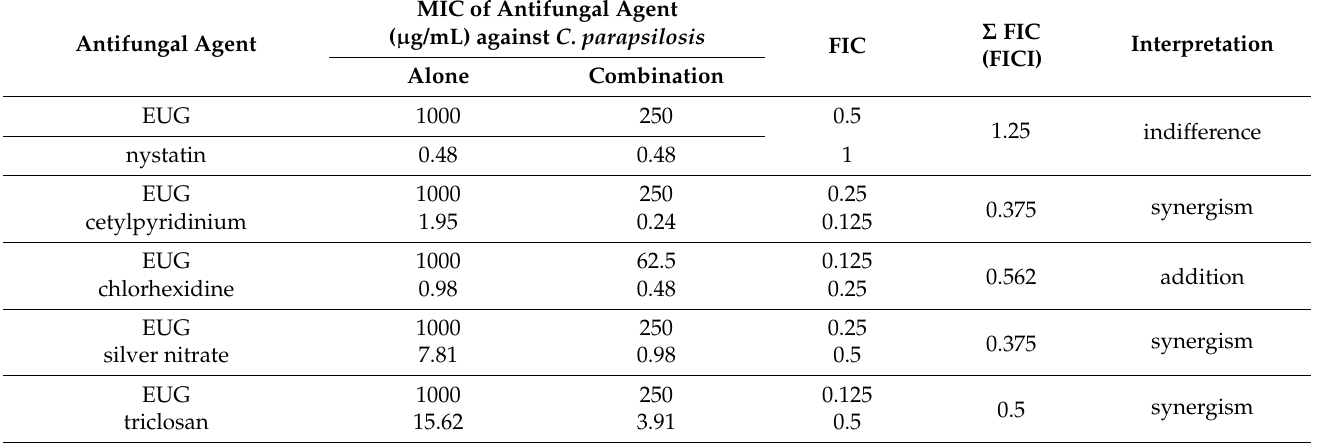
Table 12. MICs and FIC indices of EUG alone and in combination with selected antimycotics on reference C . parapsilosis ATCC 22019